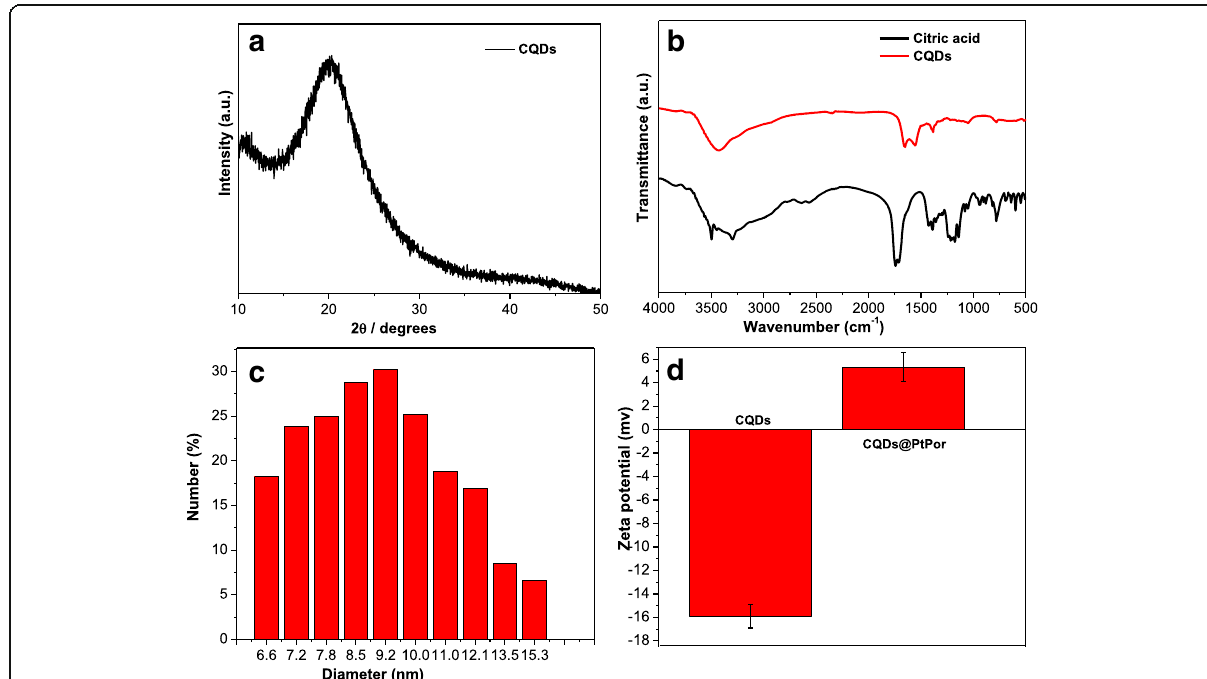
Fig. 2 XRD pattern of CQDs ( a ). The FTIR spectrum of CQDs ( b ). Particle size distribution of CQDs@PtPor measured by dynamic light scattering ( c ). Zeta potential of CQDs and CQDs@PtPor ( d )